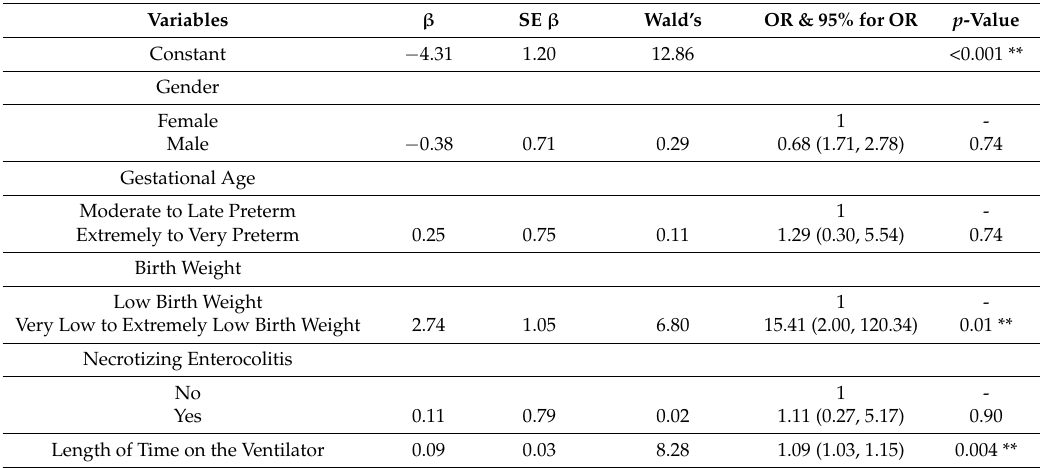
Table 5. Multivariate binary logistic regression output for neonatal